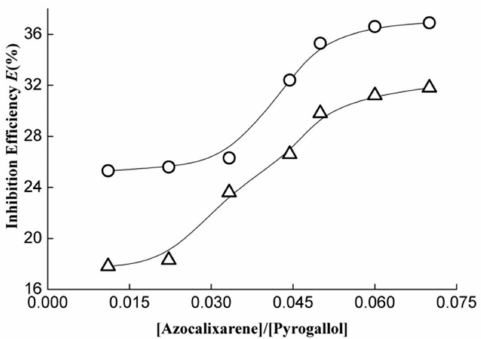
Figure 5. Pyrogallol autoxidation inhibition efficiency as a function of the concentration ratio of [azocalixarene]/[pyrogallol] where cycle ( ) and triangle ( (cid:52) ) represent azocalix[4]arene derivatives (cid:35) 1 and 2,